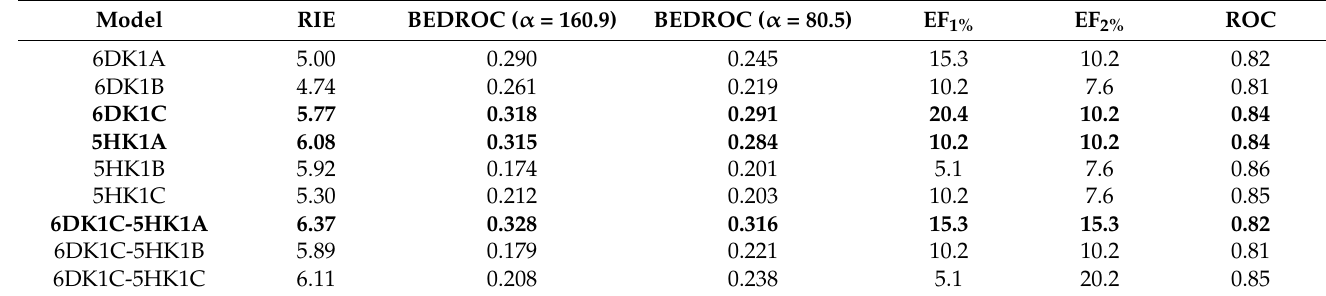
Table 1. Calculated measures of the VS efficiency using a protocol based on single chains from structures 5HK1 or 6DK1 and ensemble docking to the chain pairs 6DK1C-5HK1A, 6DK1C-5HK1B, and 6DK1C-5HK1C. Model RIE BEDROC ( α = 160.9) BEDROC ( α =